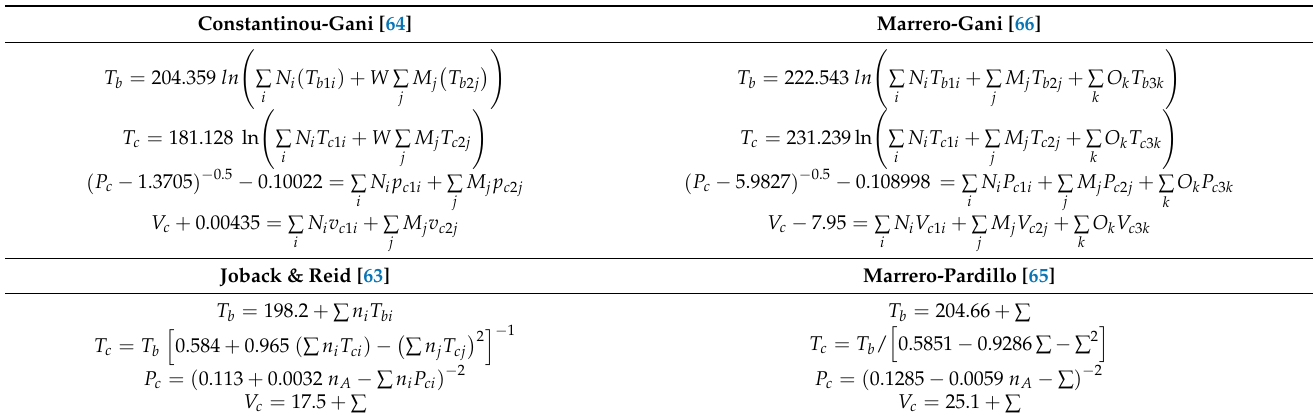
Table 1. The equations used to predict/estimate the thermo-physical (T b ) and critical properties (T c , P c , V c ) of all the compounds present in OLP, by the methods of Joback and Reid [63], Constantinou and Gani [64], Marrero-Marej ó n and Pardillo-Fontdevila [65] and Marrero and Gani